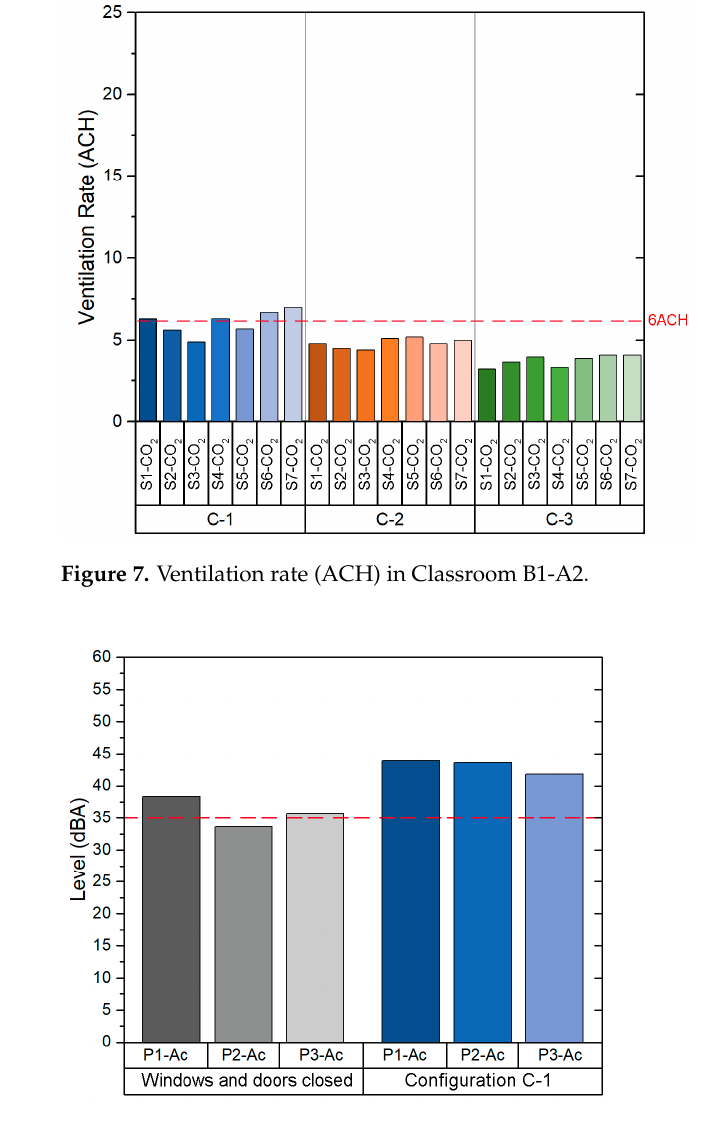
Figure 7. Ventilation rate (ACH) in Classroom B1-A2.